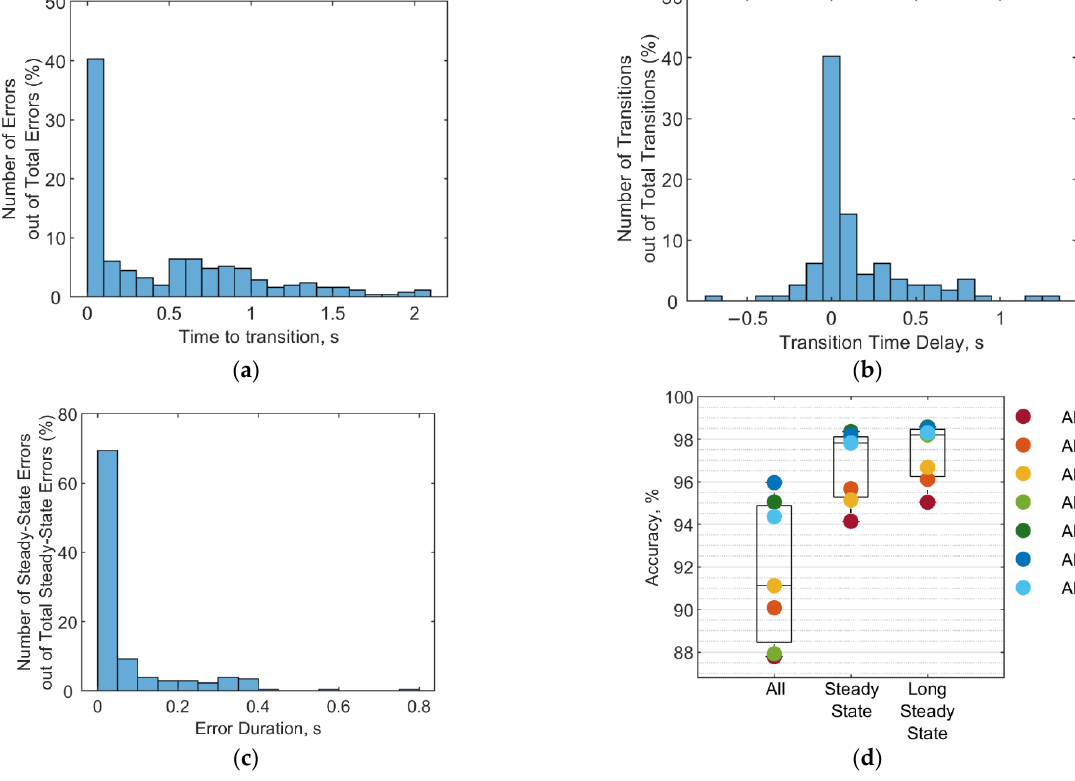
Figure 7. Error timing and duration: ( a ) Timing of errors relative to transitions among all subjects. ( b ) Distribution of transition timing delays among all subjects. ( c ) Distribution of error duration for steady state errors (those not associated with transitions). ( d ) Sonomyography classifier accuracy for three error definitions: all misclassified datapoints considered errors, only misclassified datapoints occurring during steady state considered errors, and only misclassifications occurring during steady state and of greater than 50 ms considered errors. The median, interquartile range, and total range for the group are shown in the boxplot. The colored points show individual